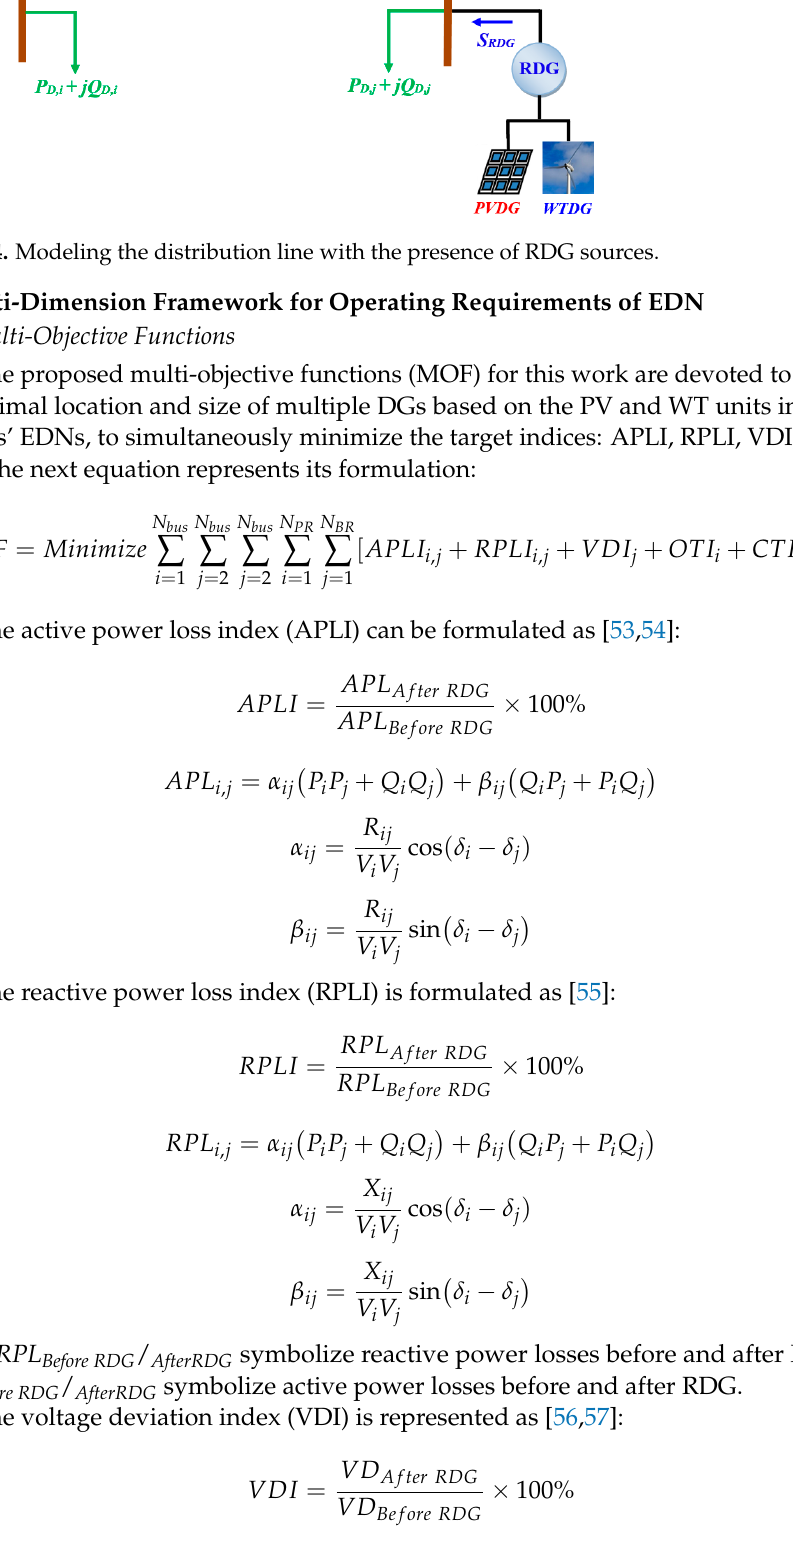
Figure 3. The seasonal variation of WTDG output power. Figure 4 represents the distribution line k that is represented with an impedance + 𝑗𝑋 𝑅 (cid:3036)(cid:3037) (cid:3036)(cid:3037) that is connected between buses i and j , with the installation of PV and based RDG.